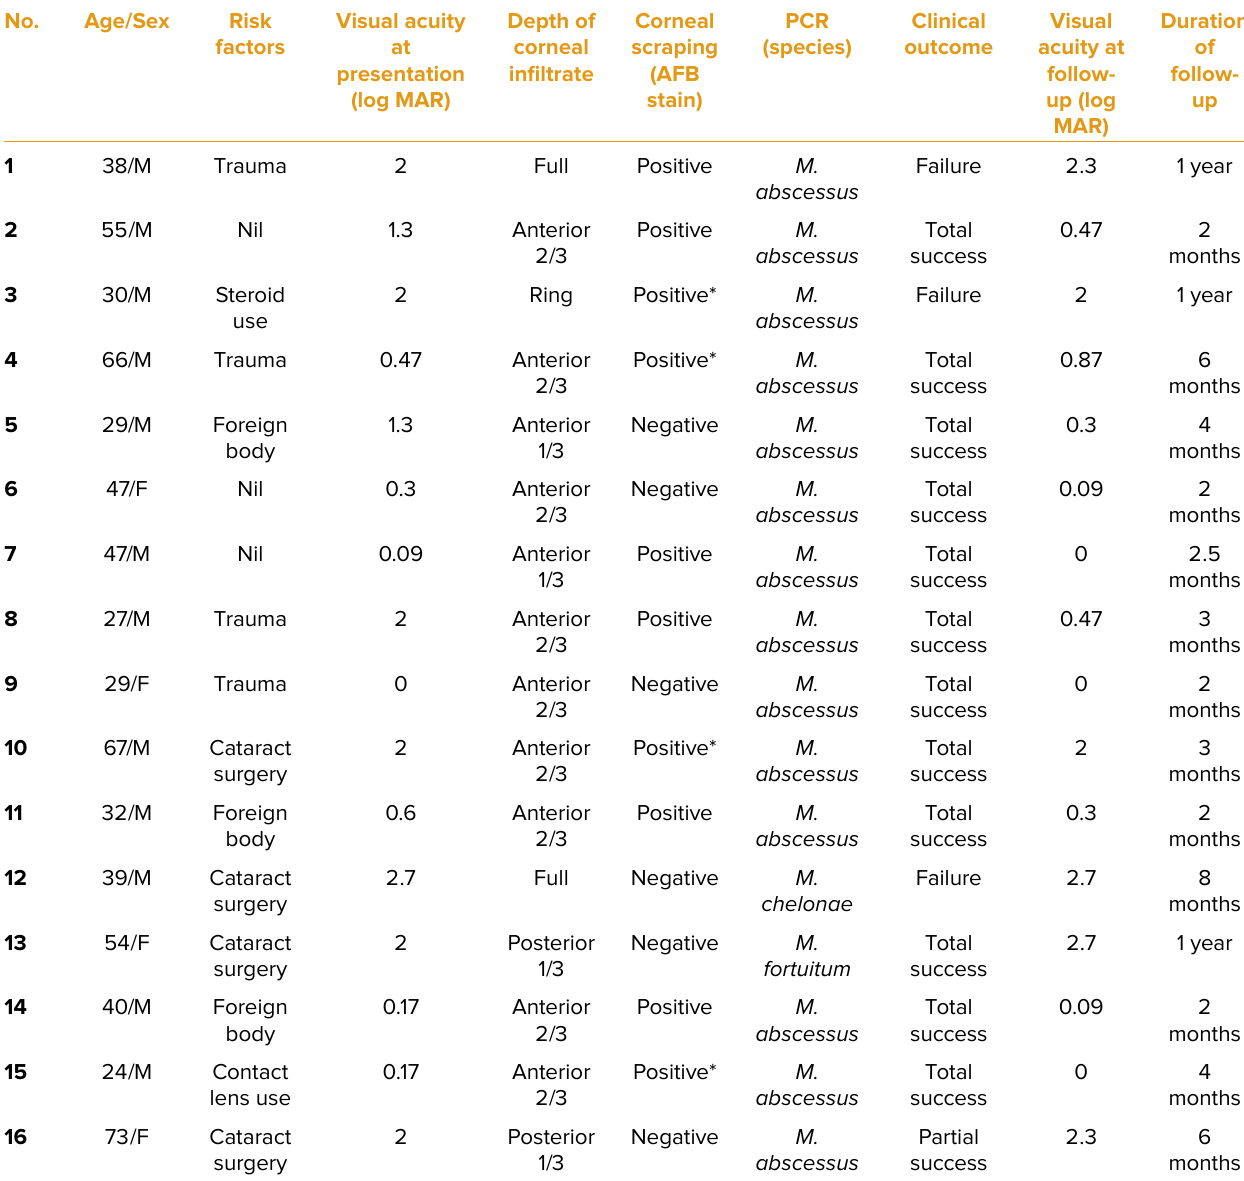
Table 1. Clinical and microbiological details of 16 patients with NTM keratitis. No.